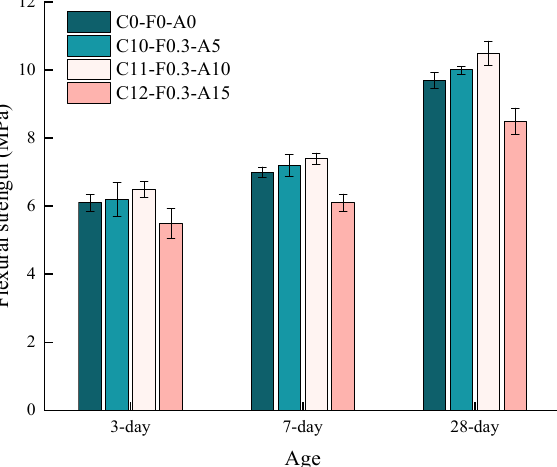
Figure 12. Flexural strength of cementitious mortars at different ages by the coordinated action of YDF and YDA.